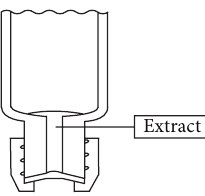
Figure 4: Sketch of the lower side of a gas sampling tube in the vertical position: the exhaled breath extract (the isooctane phase) is located within the cylindrical hole.